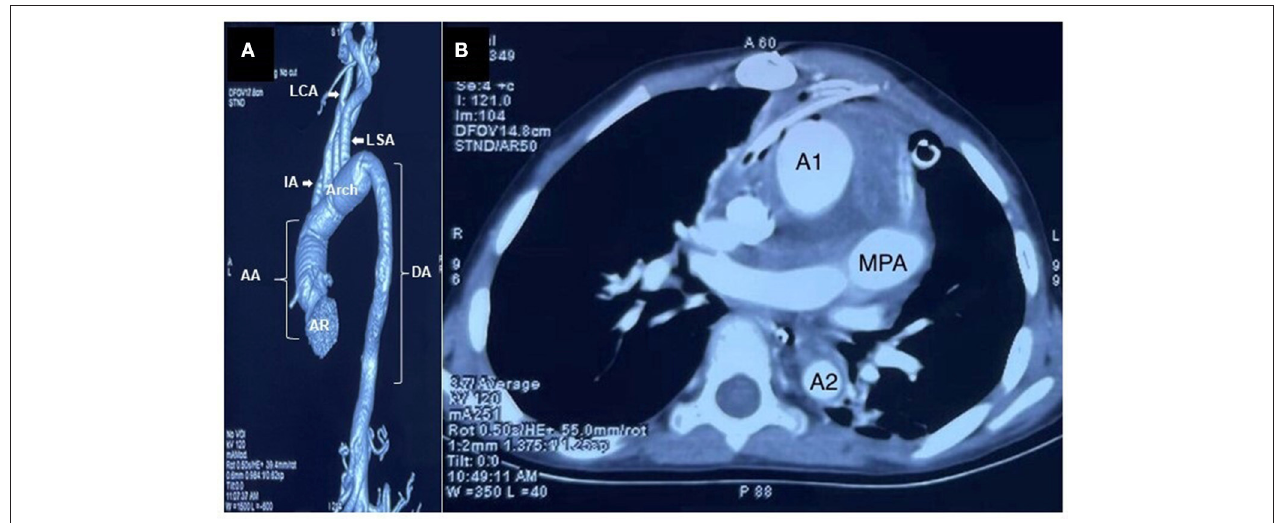
FIGURE 3 | Images after the valve-sparing operation along with an aortic arch replacement. (A) Contrast-enhanced CT image (volume rendered) showed significant reduction in the caliber of the aorta (AR—aortic root, AA—Ascending Aorta, DA—Descending Aorta, LCA—Left common Carotid Artery, LSA—Left Subclavian Artery, IA—Innominate Artery). (B) Post valve-sparing surgery along with the aortic arch replacement, a CT aortogram section (axial view) at the level and just below the main pulmonary artery (MPA) showed significant reduction in the caliber of ascending aorta (A1) and descending aorta (A2). Minimally enhancing soft tissue thickening was